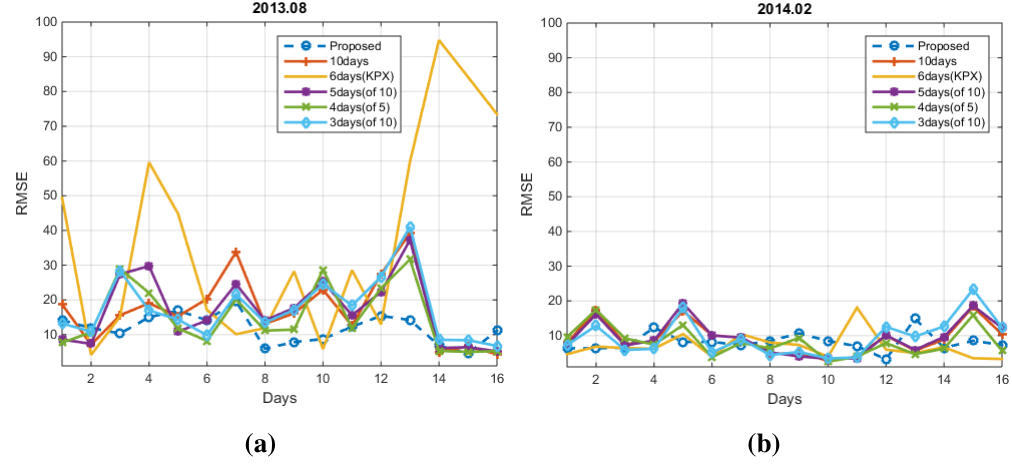
Figure 10. RMSE evaluation of site C in summer season ( a ) and winter season ( b